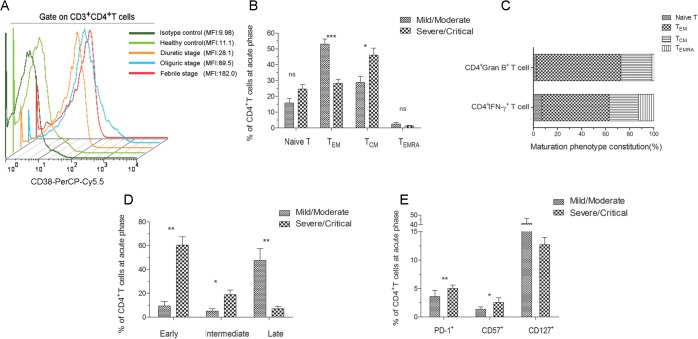
Analysis of the active, memory or differentiation phenotypes of HTNV-Gn/Gc-specific CD4+T cells in HFRS patients.(A) Representative histogram of CD38 expression on HTNV-Gn/Gc-specific CD4+T cells during different stages of the disease. FACS contour plots were gated on CD3+CD4+T cells. (B) Comparison of the memory phenotype constitution percentage of naïve (CCR7+CD45RA+), effector memory (CCR7–CD45RA–), central memory (CCR7+CD45RA–) and transitional effector memory (CCR7–CD45RA+) CD4+T-cell subsets in mild/moderate patients and severe/critical patients during acute HFRS. (C) The memory phenotype constitution percentage in IFN-γ or granzyme B-producing CD4+T cells. (D) Comparison of the differentiation phenotype percentage of early (CD27+CD28+), intermediate (CD27–CD28+) and full differentiation (CD27–CD28–) CD4+T-cell subsets in mild/moderate patients and severe/critical patients at acute stage of HFRS. (E) Comparison of the PD-1, CD57 and CD127 expression on CD4+T cells in mild/moderate and severe/critical patients during acute phase of HFRS. The Wilcoxon rank sum test was used for statistical evaluation; *P<0.05, **P<0.01, *** P<0.001, ns, not significant. MFI, mean fluorescence intensity; Gran B, granzyme B.